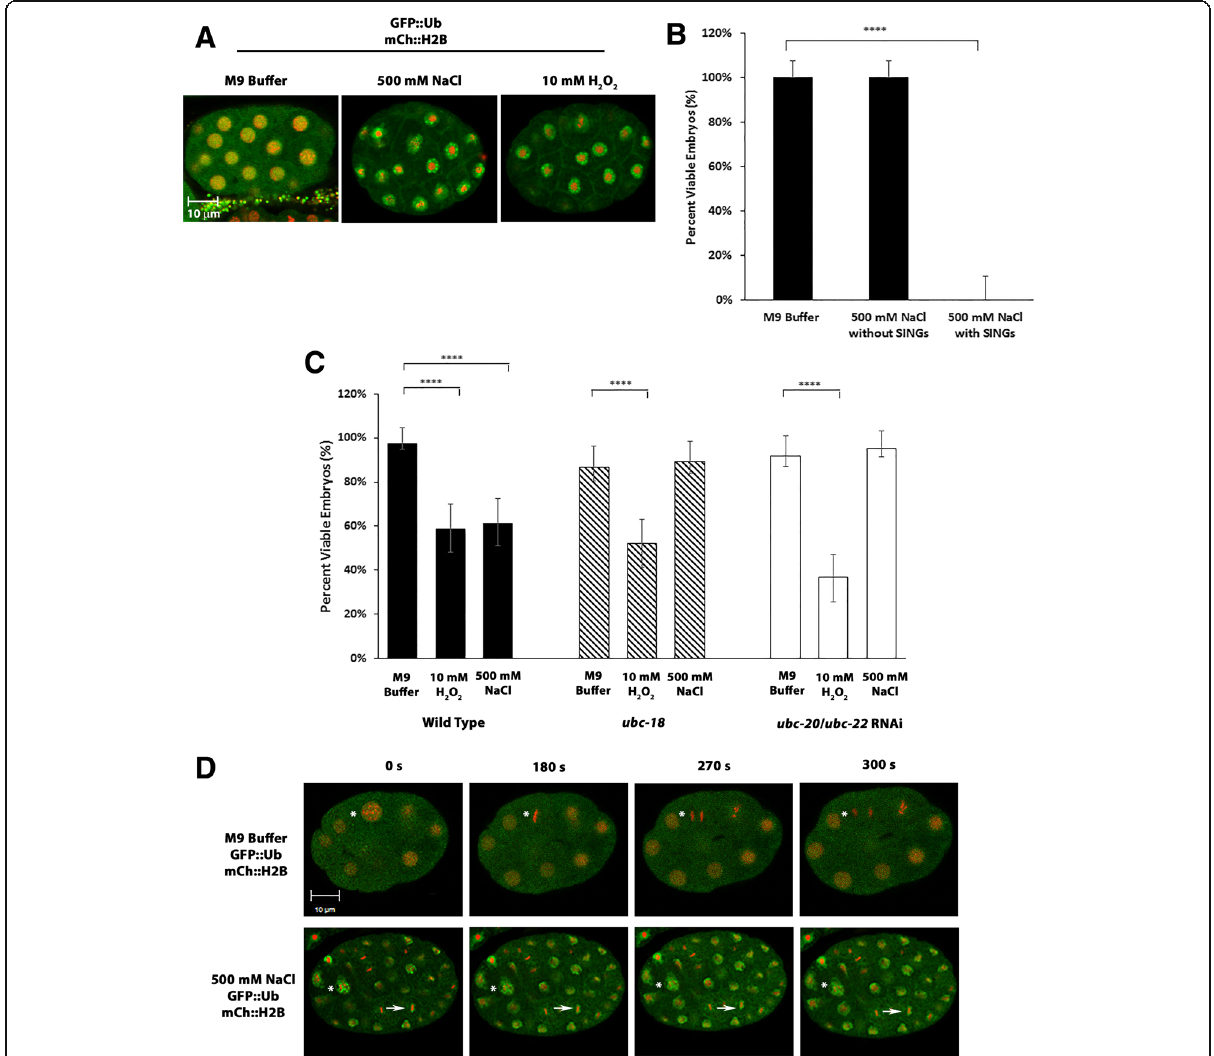
Fig. 10 SINGs correlate with embryonic lethality and impaired cell division. a Stress induces SING formation in embryos. Embryos were obtained from worms expressing GFP::Ub and mCh::H2B and placed in 500 mM NaCl for 1 h or 10 mM H 2 0 2 for 30 min. Embryos formed SINGs under both types of stress conditions. Scale bar indicates 10 μ m. b Hatching rate of embryos that contain SINGs. Embryos were dissected from gravid adults that were soaked in M9 (unstressed) or 500 mM NaCl (stressed) for 1 h. Stressed embryos were screened under the microscope for the presence of SINGs. Embryos with SINGs showed a 0% hatch rate versus a 100% hatch rate for unstressed embryos or stressed embryos without SINGs. A total of 40 embryos were analyzed for each condition from 3 independent experiments. Statistical significance was calculated by a Fisher ’ s Exact test: **** p < 0.0001. c Hatching rates of wild type and ubc-18 mutant embryos in unstressed and stressed conditions. Embryos were subjected to two different stresses: salt stress (500 mM NaCl for 60 min) and oxidative stress (10 mM H 2 O 2 for 30 min). Both types of stress reduce the hatching rate of wild type embryos. However, in ubc-18 or ubc-20/ubc-22 (RNAi) embryos which have reduced SING formation, salt stress does not reduce the hatching rate. Oxidative stress does reduce hatching rate in ubc-18 and ubc-20/ubc-22 (RNAi) embryos. In ubc-18 and ubc-20/ubc-22 (RNAi) embryos, the numbers for the M9 and the 500 mM NaCl hatching rates showed no statistical difference. Experiments were repeated three times with 25 embryos per trial for a total of 75 embryos per condition. Statistical significance was calculated by a Fisher ’ s Exact test: **** p <0.0001. d Time-lapse imaging on unstressed and stressed embryos expressing GFP::Ub and mCh::H2B. Ten embryos from the unstressed and ten embryos from the salt stressed groups were observed on the confocal microscope with time-lapse imaging for 15 min each. Many cells in each unstressed embryo were able to complete cell division within 5 min. Cells in salt stressed embryos showed no progression through the cell division cycle. The asterisk in the M9 embryo shows a cell that proceeds through prophase, metaphase, and anaphase of the cell cycle. The asterisk in the 500 mM NaCl embryo shows a nucleus that has SINGs and remains in prophase. The arrow shows a nucleus with SINGs that remains in metaphase throughout the 15 min observation period. A total of 10 embryos were collected from 3 independent experiments. Scale bar indicates 10 μ